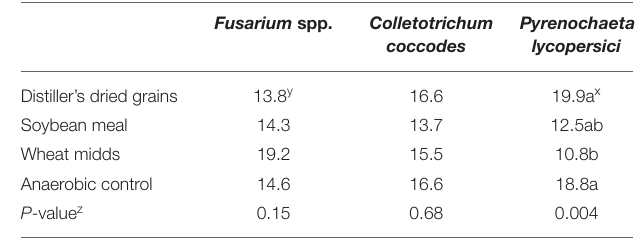
TABLE 6 | Average incidence of root piece infection by various fungi for plants grown in post-ASD bioassays using soils treated on-farm with anaerobic soil disinfestation with various carbon sources (20.2